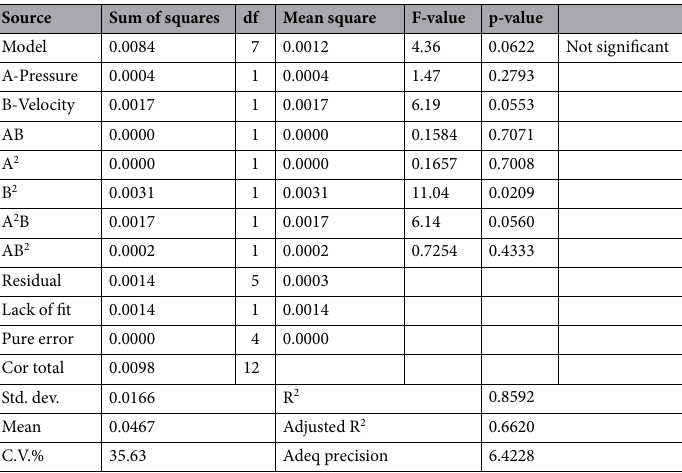
Table 19. ANOVA results for quadratic model (high peaks zone is response) of QAM f